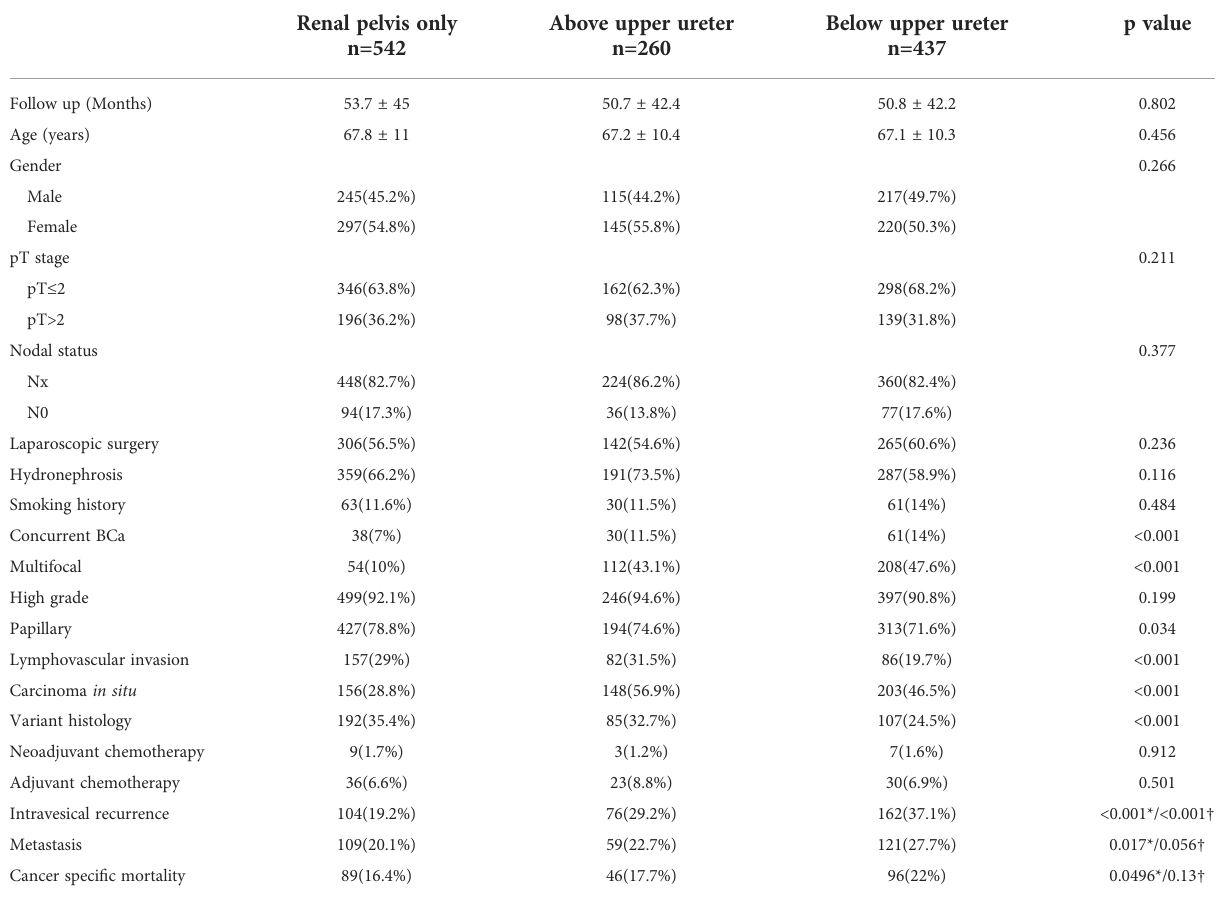
TABLE 1 Clinicopathologic